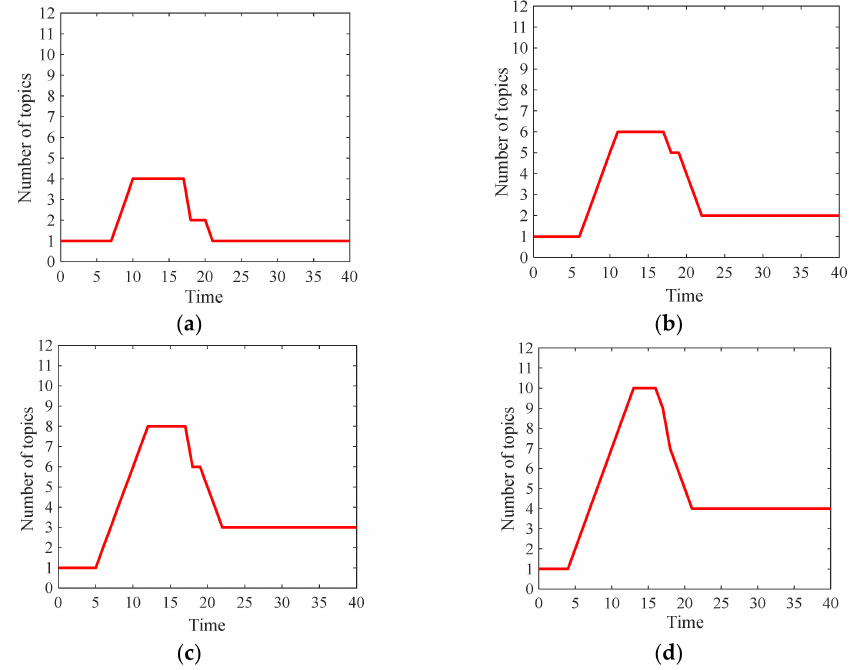
Figure 17. The change of the number of subtopics under different environmental forces. ( a ) δ = 3. ( b ) δ = 5. ( c ) δ = 7. ( d ) δ =